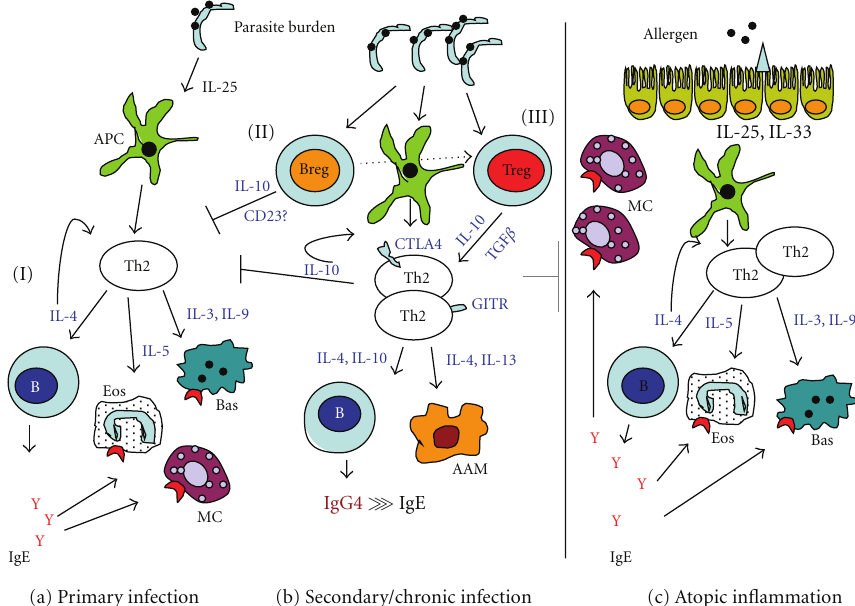
Figure 1: Possible regulatory mechanisms in helminth infections. Primary response (a) to parasite antigens involves Th2 polarization, IgE production, and eosinophil, mast cell, and basophil activation (I), mechanisms similar to those observed in allergic sensitisation (c). This Th2-response may be induced by parasite-secreted antigens such as the Omega-1 secreted by S. mansoni eggs [25]. However, with increasing parasite load or chronic infection (b), regulatory B cells are activated which suppress Th2 responses (II) via IL-10 secretion or CD23 expression [26], and/or contribute to the recruitment of Tregs [27]. Tregs (III), which may also be induced and expanded by parasite antigens [28, 29], either induce anergic Th2 cells (expressing GITR and CTLA4) unable to progress through to e ff ector cells, or modify downstream e ff ector functions such as B cell switch to IgG4 and/or alternative activation of macrophages, resulting in immunological tolerance (reviewed by [30]). This immunosuppression is induced in the context of helminth infection, but may also expand to allergen- induced inflammation (gray line), hence suppressing allergy. DC: dendritic cell; B: B cell, Eos: eosinophil; Bas: basophil; MC: mast cell; GITR: glucocorticoid-induced TNF α -related protein; CTLA4: cytotoxic T lymphocyte antigen 4; AAM: alternatively activated macrophage; Breg: regulatory B cell; Treg: regulatory T cell. The question mark (?) denotes lack of strong evidence. Figure adapted from [30, 31] and collated information from the cited